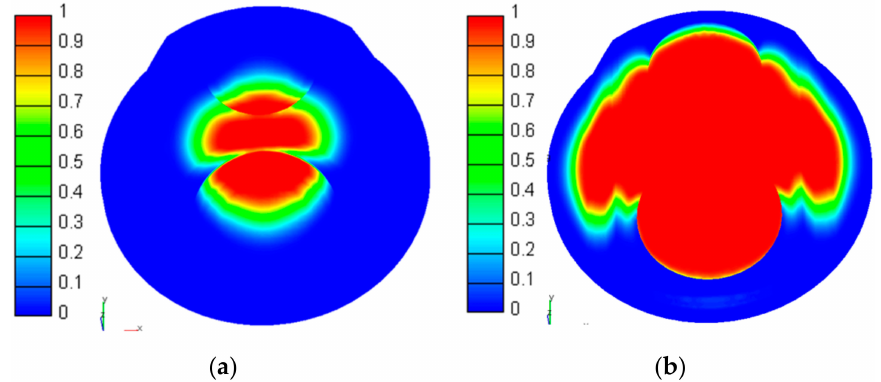
Figure 10. Combustion reaction progress variable at 10 ◦ CA after the top dead center (aTDC): ( a ) 20% EGR; ( b ) 10%